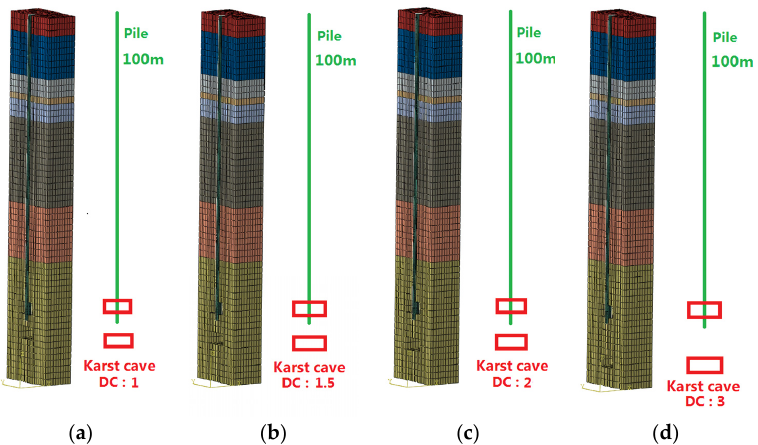
Figure 9. Schematic diagram of the finite element model of the rock-socketed pile with different DCs of the karst cave under pile. ( a ) DC at 1, ( b ) DC at 1.5, ( c ) DC at 2, and ( d ) DC at